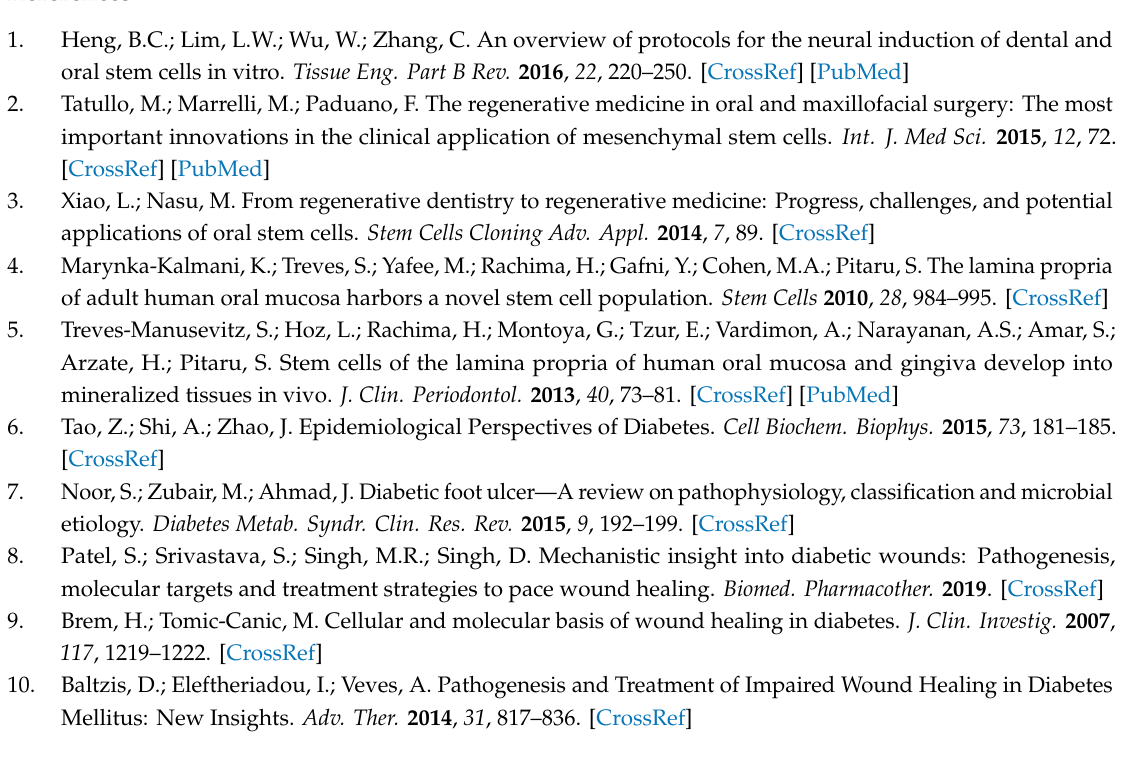
Figure S1: Immunophenotype of Balb / c mouse oral mucosa stem cells